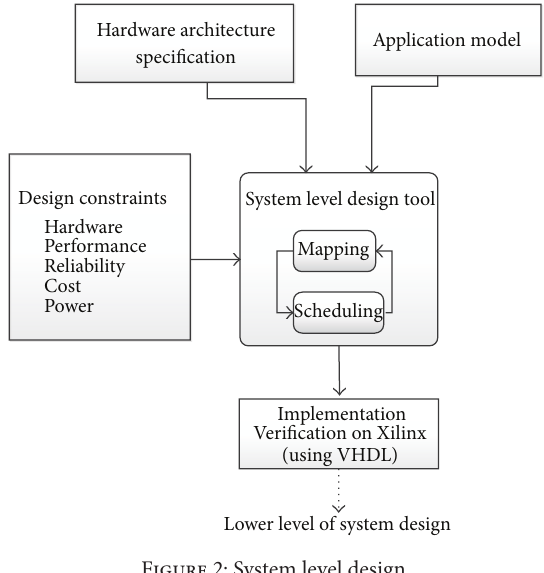
Figure 2: System level design.